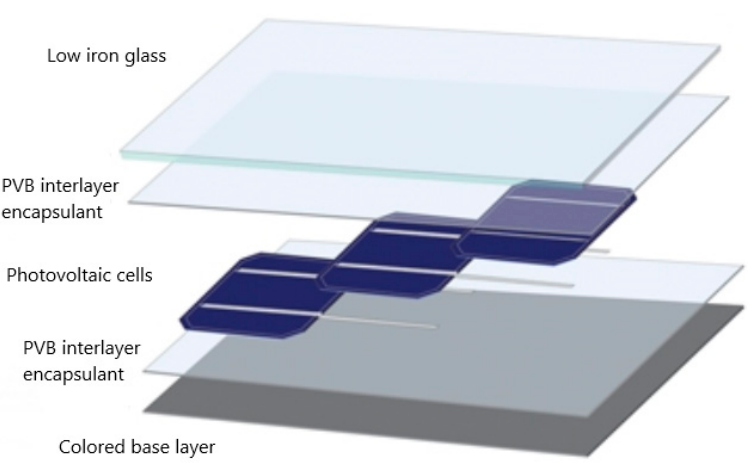
Figure 3. Solar panel composition used polyvinyl butyral (PVB) interlayer encapsulate. For durability of the module and the long-term production of energy, the cell